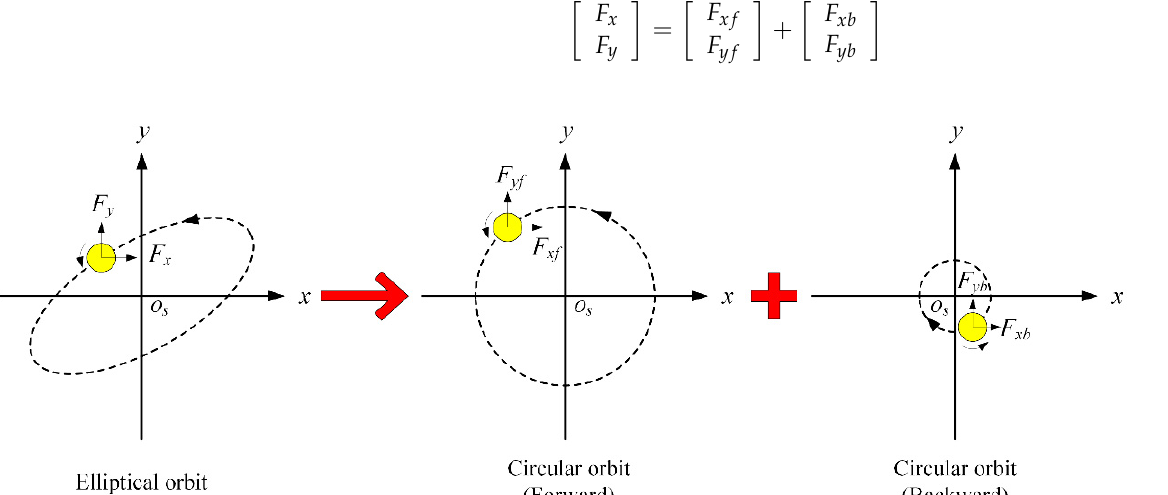
Figure 5. Fluid-induced force superposition based on orbit decomposition method. In Figure 5 and Equation (12), the fluid-induced forces F x and F y are positive when they are in the positive directions of the x -axis and y -axis, respectively. Conversely the fluid-induced forces F x and F y are negative when they are in the negative directions of the x -axis and y -axis, respectively.